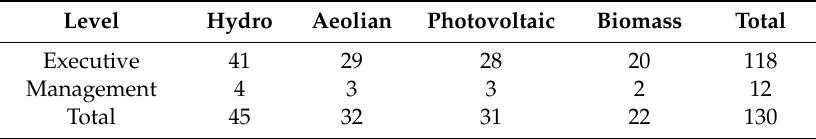
Table 4. Distribution of the